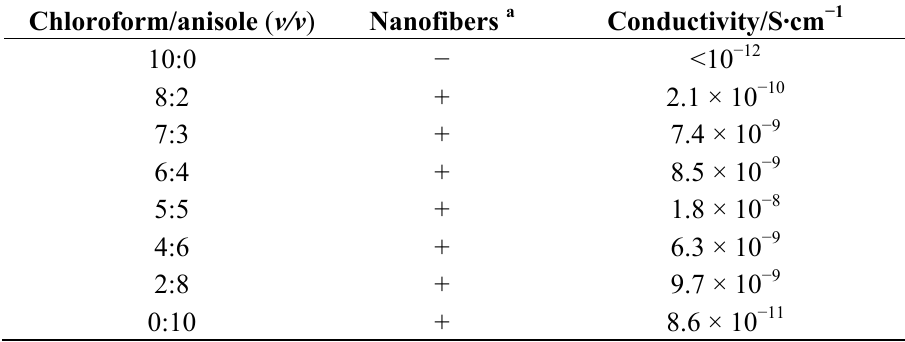
Table 1. Conductivity of composite films produced from different solvent